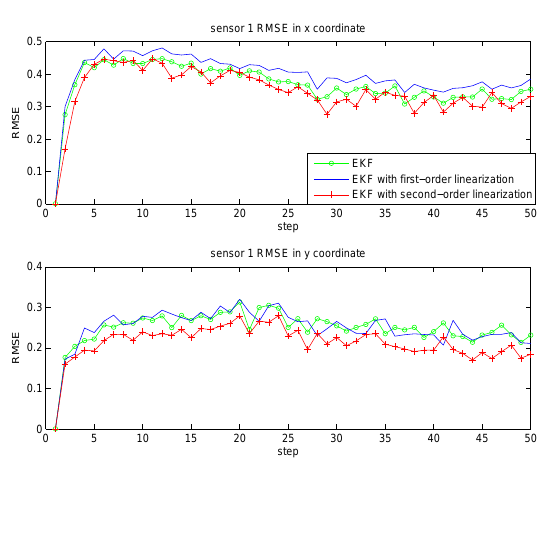
Figure 3. RMSE of sensor